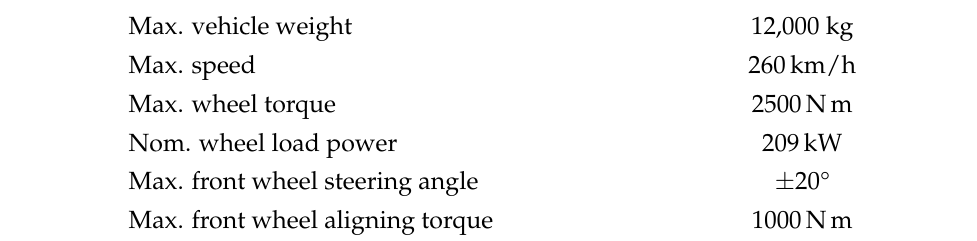
Table 1. Technical parameters of the ViL test bench